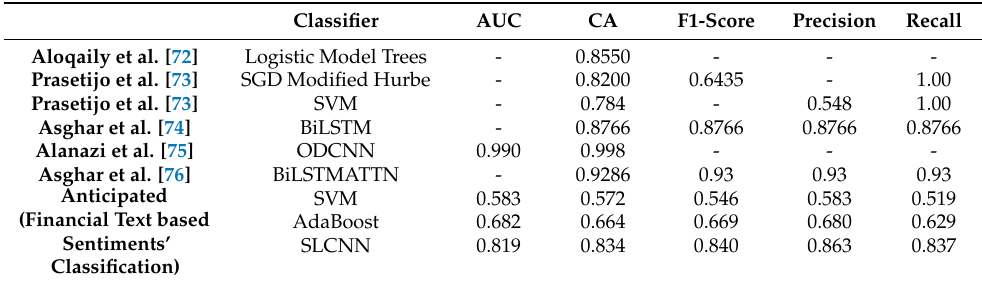
Table 10. Performance comparison of the anticipated text classification